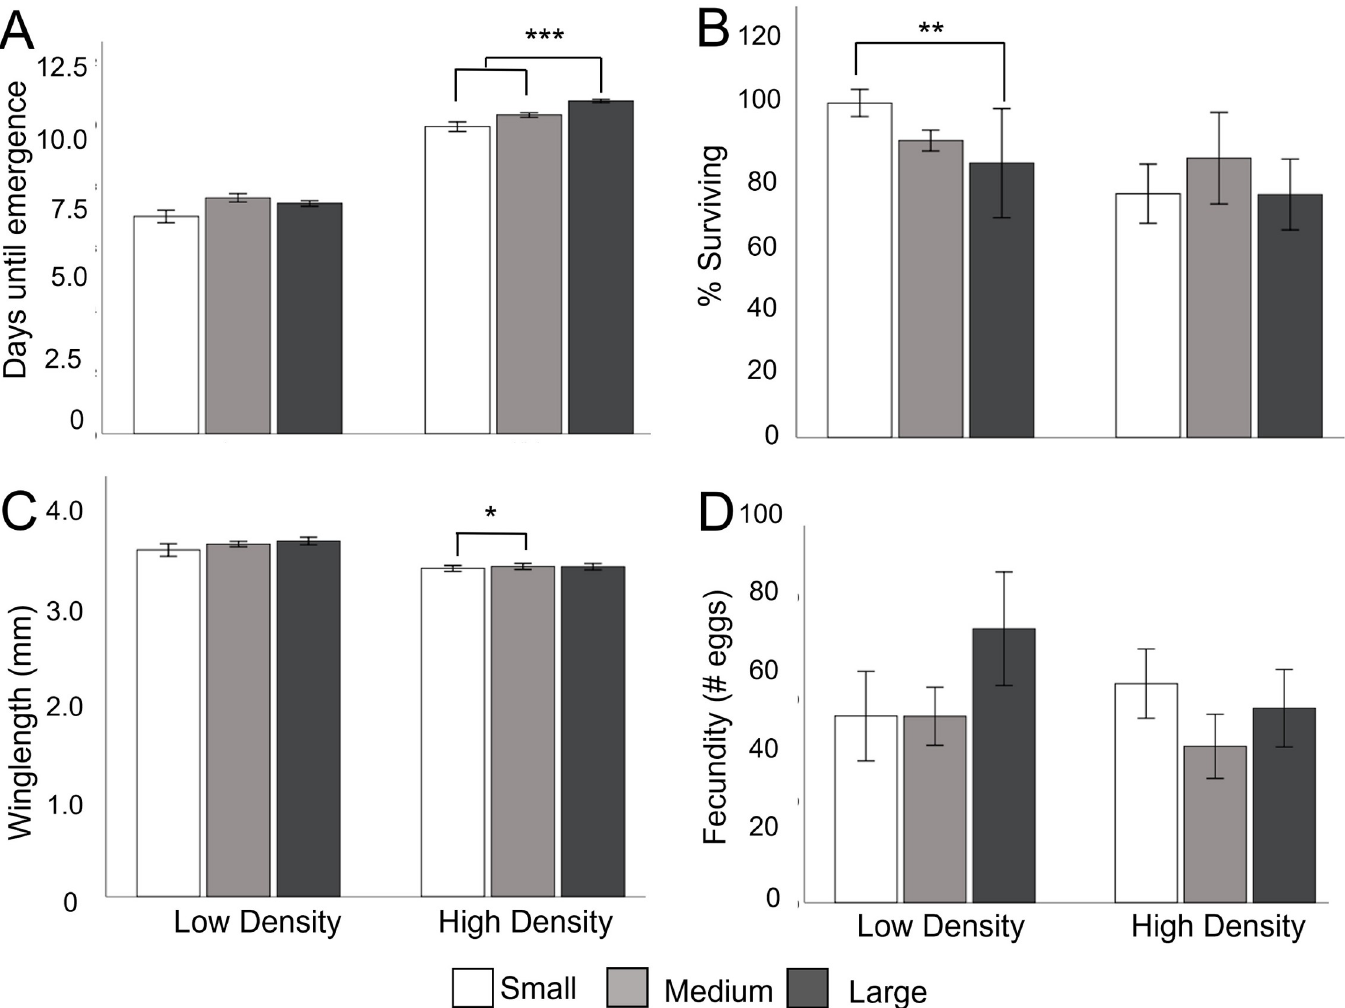
Fig 4. The effect of density and container size on development, size, and fecundity. A. Days from hatching to emergence of adult mosquito. Numbers averaged across the five replicates for each container size for each diet type. There were a total of n = 20, n = 100, and n = 200 individuals, for each replicate, for small, medium and large containers respectively for low density conditions and n = 1400, n = 700, and n = 140 for each replicate for small, medium, and large containers for high density conditions. B. Percentage of first instar larvae surviving to adult emergence . Proportions taken from 4 replicate trays for large and medium contains and 5 for small containers. C. Female wing length across replicate trays for each container size (sample size were high density; small = 33, medium = 28, large = 28, low density; small = 25, medium = 18, large = 25). D. Eggs laid per female. Numbers averaged across the five replicates for each container size for each diet type. (sample sizes were high density; small = 32, medium = 27, and large = 27. low density; small = 21, medium = 16, large = 22). Error bars represent ± SE. The bars and asterisks represent significant pairwise differences from a Tukey’s post doc test where � = P < 0.05, �� = P < 0.01 and ��� = P < 0.0001 between container size treatments within the same density